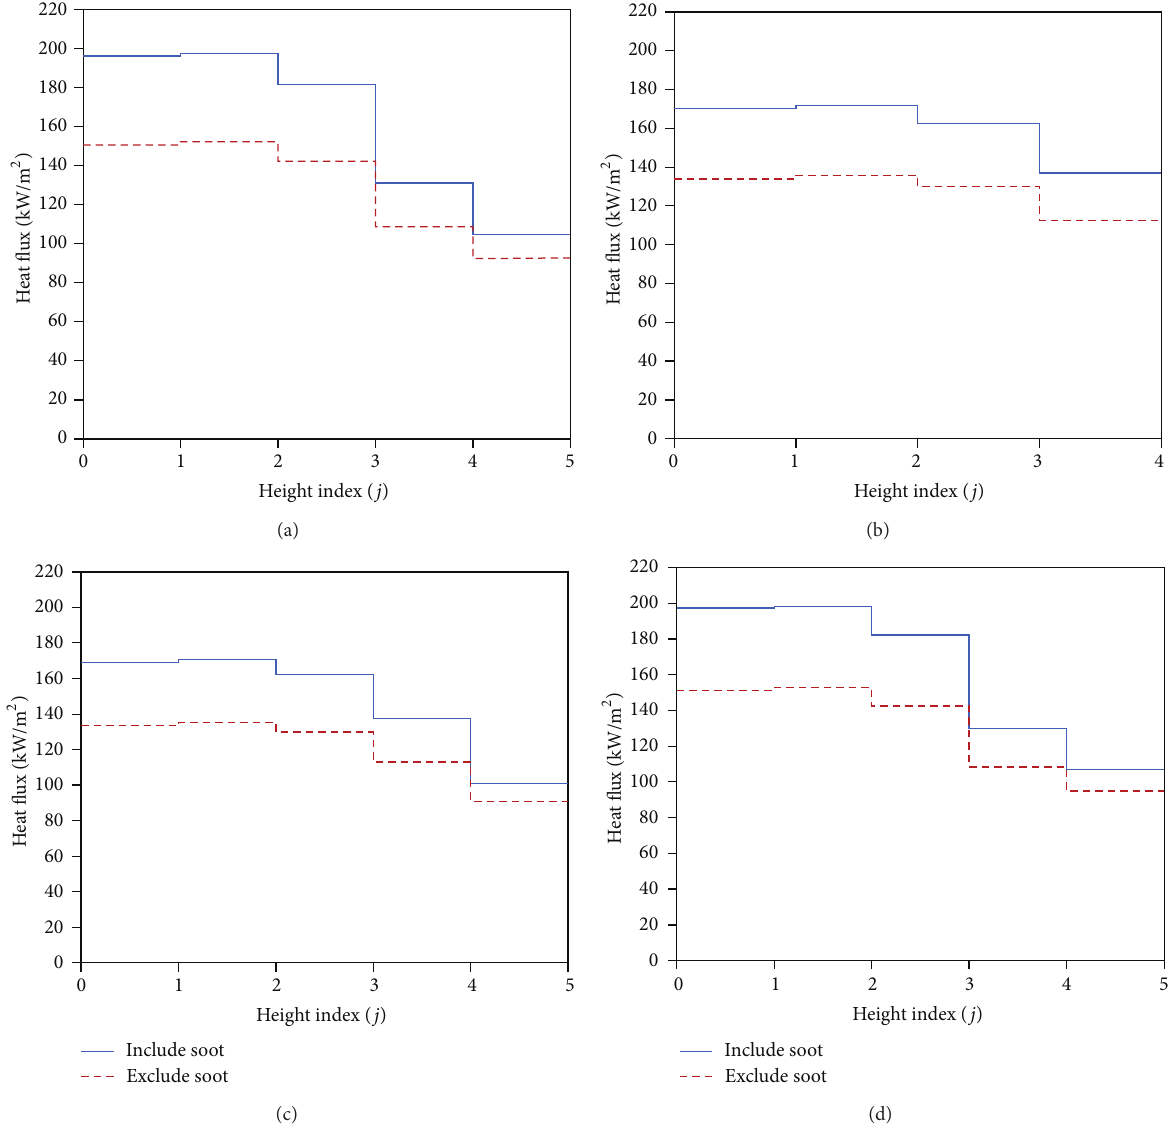
Figure 6: Heat flux distribution with and without soot particles along the (a) front wall ( 𝑖 = 1, 𝑗 ), (b) front wall ( 𝑖 = 2, 𝑗 ), (c) right wall ( 𝑘 = 1, 𝑗 ), and (d) left wall ( 𝑘 = 1, 𝑗